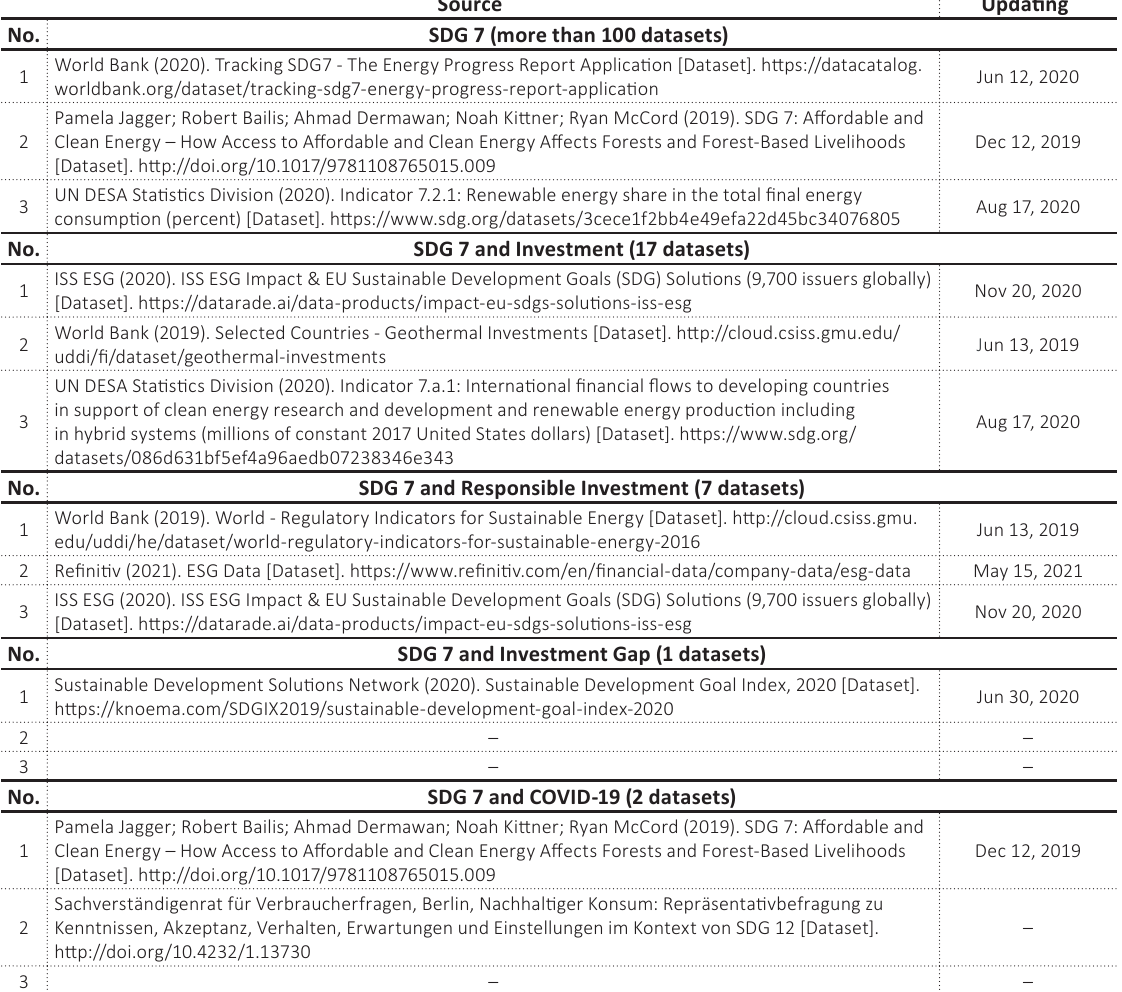
Table F1. Examples of source in each research areas, generated via Google Public Data Explorer as of December 25, 2022 Source Updating No. SDG 7 (more than 100